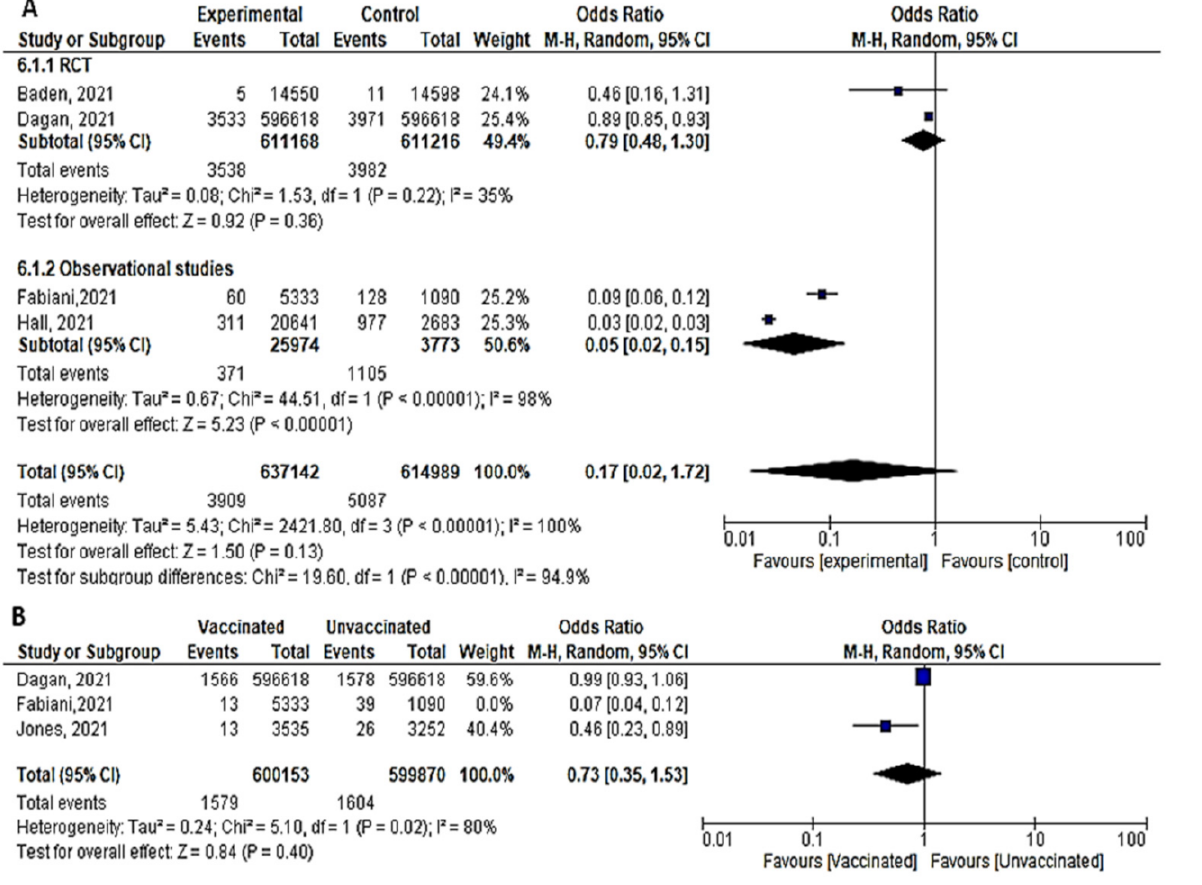
Figure 6. ( A ) Incidence of SARS-CoV-2 infection either symptomatic or asymptomatic within 14 days of 1st dose of vaccination. ( B ) Incidence of asymptomatic SARS-CoV-2 within 14 days of 1st dose of